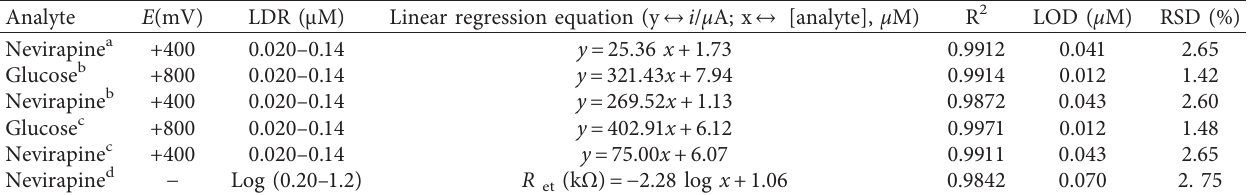
Table 2: Analytical parameters for electrochemical determination of nevirapine in 0.1 M PBS at pH 11.0. Analyte E (mV) Glucose b Glucose